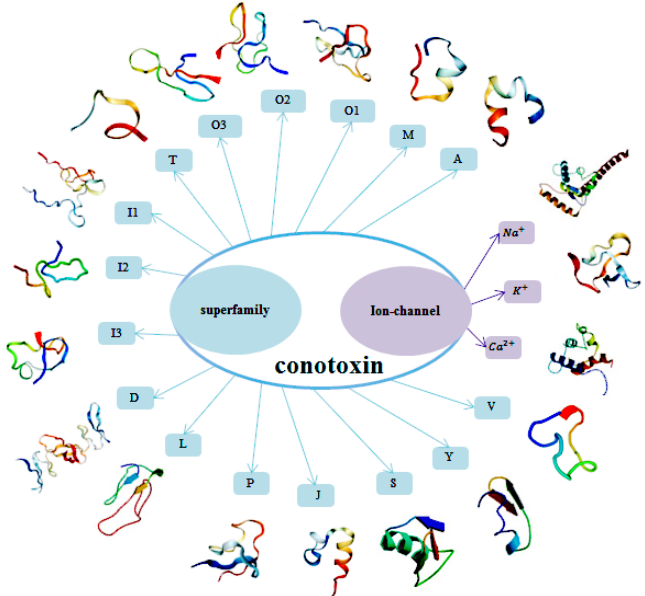
Figure 1. A structural schematic illustration to show the classification of conotoxins in superfamily and ion channel-target. Sixteen major conotoxin superfamilies are A, D, I1, I2, I3, J, L, M, O1, O2, O3, P, S, T, V, and Y. They are also categorized into calcium channel-targeted, sodium channel-targeted, and potassium channel-targeted conotoxins according to their functions.